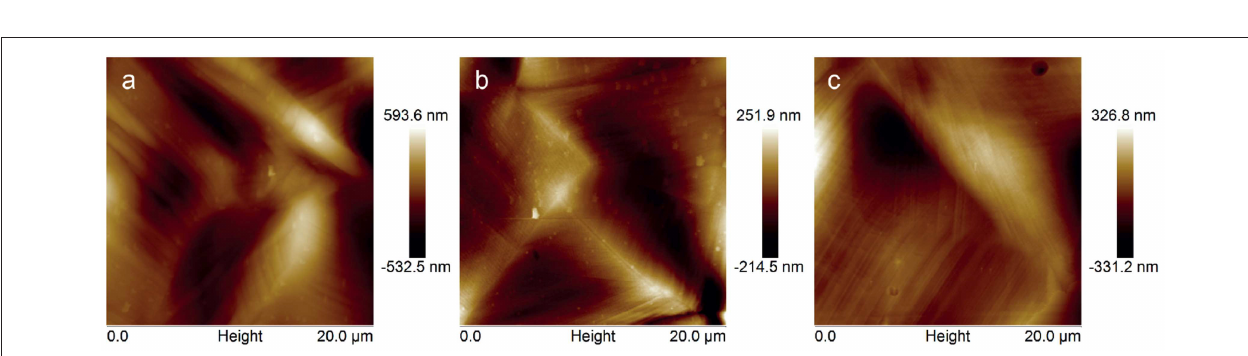
FIGURE 4 | AFM topography images of the topmost part of CF x -A (a) , CF x -B (b) , and CF x -C (c) samples after application of 25%